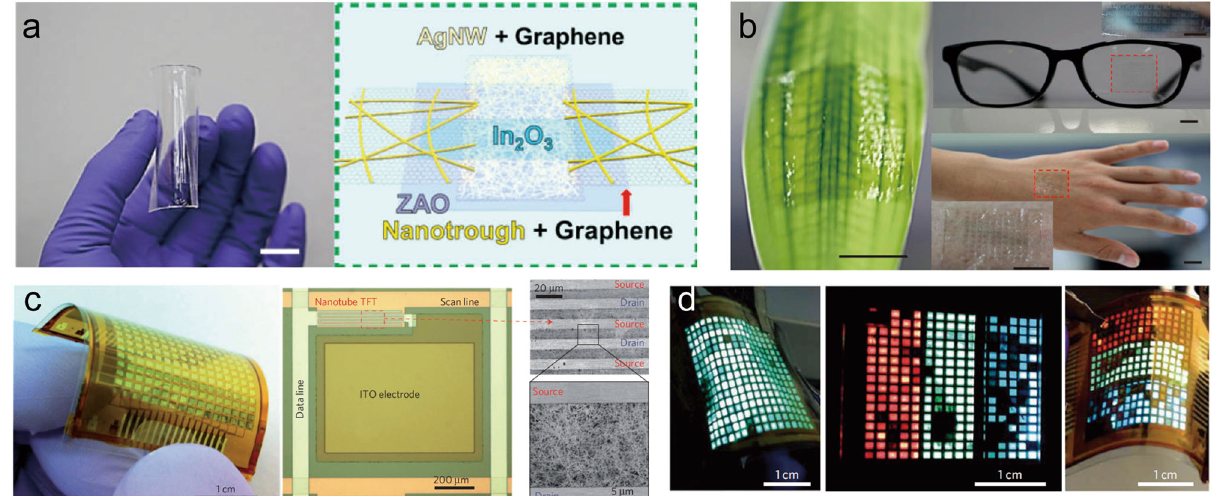
Fig. 2 Flexible backplane for display fabricated by a thin- fi lm process. a Photo ( left ) of the TFT array sample made by graphene – AuNT hybrid electrodes on a transparent polyimide substrate. Scale bar : 1 cm. A schematic diagram ( right ) of the TFT layout. b Photos of the TFT arrays transferred onto: a leaf, eyeglasses, and the skin of human hand. All scale bars : 1 cm. a – b Reproduced with permission from ref. 8. Copyright 2014, American Chemical Society. c Photo ( left ), optical micrograph ( middle ), and scanning electron micrographs ( right ) of fl exible backplane. d Photos of operating fl exible display combined with backplane and OLED pixels. c – d Reproduced with permission from ref. 3. Copyright 2013, Nature Publishing